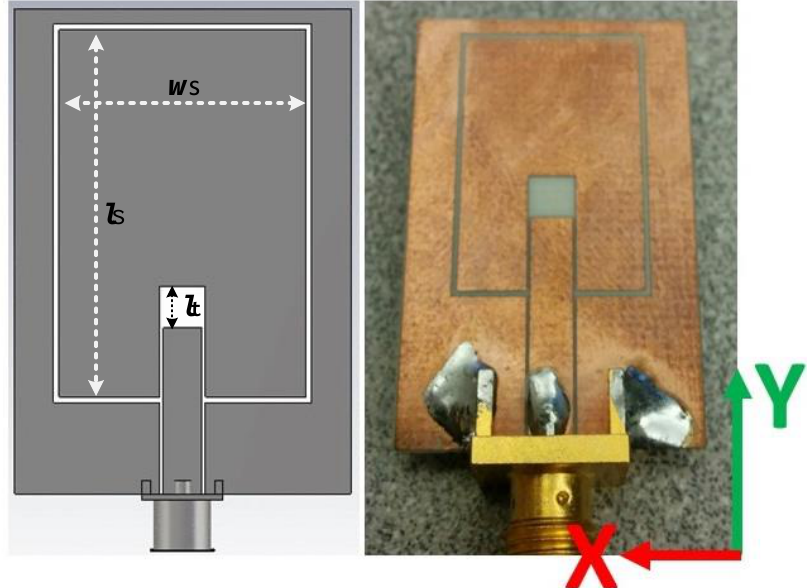
Figure 1. Configuration of the proposed CPW antenna.